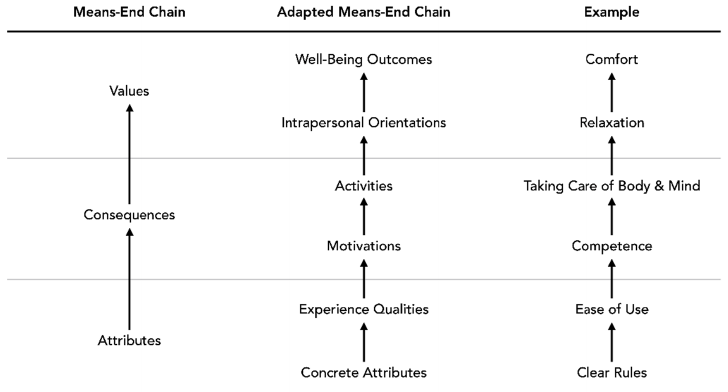
Figure2. Means–endchain, MEC( left ), adaptedMECusedintheladderingstudy( middle )andexample Figure 2. Means–end chain, MEC ( left ), adapted MEC used in the laddering study ( middle ) and MEC ( right ); visualization adapted from Wiese et al. example MEC ( right ); visualization adapted from Wiese et al. [46,57].